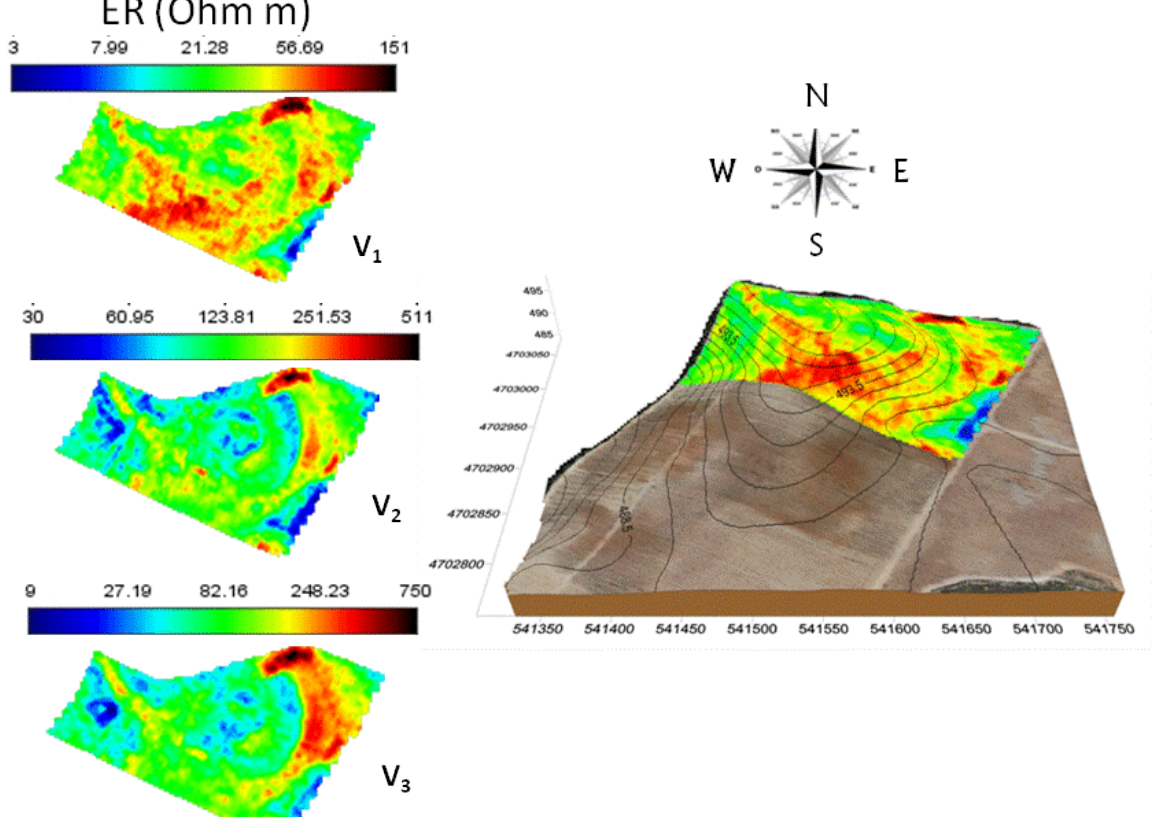
Figure 4. Interpolated maps ( left ) of ER measured by the ARP system in the three soil layers (V = 0–0.5, V = 0–1 and V = 0–2 m depth). Interpolated map ( right ) of the 1 2 3